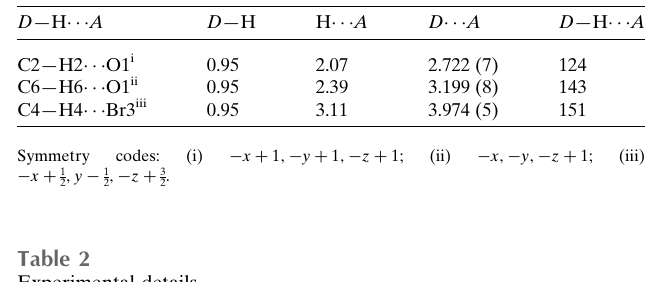
Table 2 Experimental details.